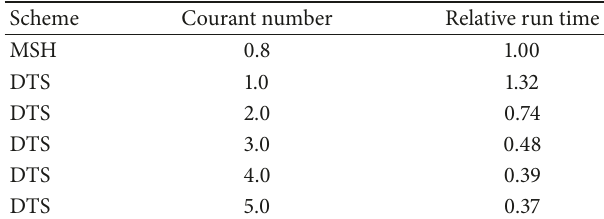
Table 1: Relative run time of various